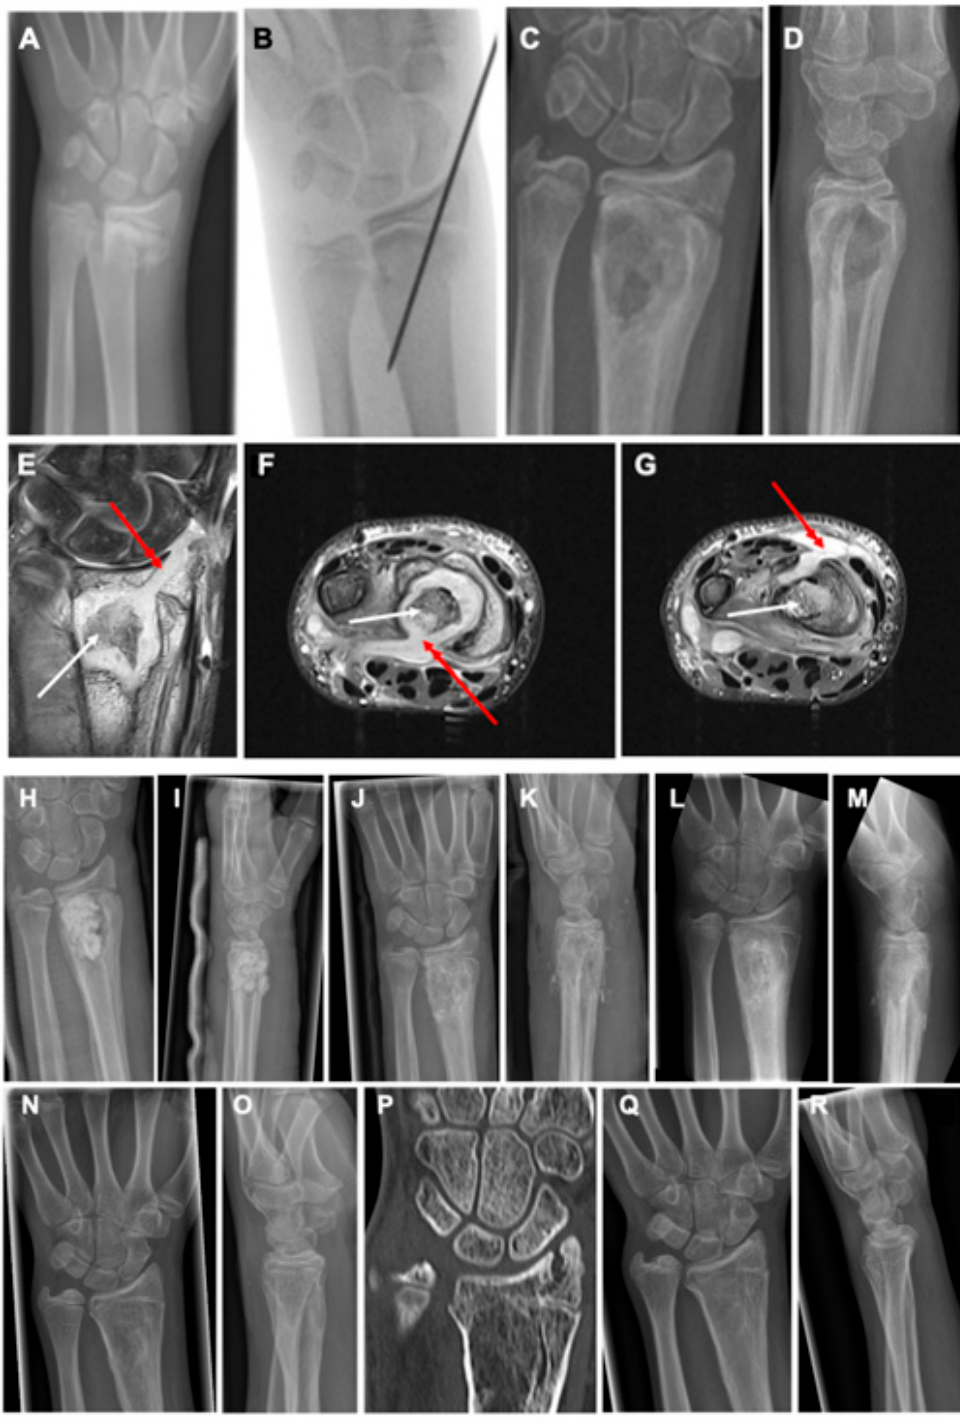
Figure 1. A 13-year-old male patient sustained a dislocated fracture of the distal radius and an undislocated distal ulna fracture after a bicycle accident ( A ). Closed reduction and percutaneous K-wire fixation was performed with epicutaneous placement of the K-wire ( B ). Four weeks after surgery, the boy presented with acute redness and swelling at the distal forearm with high suspicion of a fracture-related infection. The K-wire was completely loosened and removed before X-ray control ( C , D ). X-rays showed a healed fracture with severe osteolysis in the metaphyseal region with accompanying periosteal reaction. MRI confirmed severe osteolysis in the metaphyseal region with more details, such as abscess and sequestrum formation (white arrows) and affection of the growth plate and epiphysis through the channel, where the K-wire had initially been placed on coronal